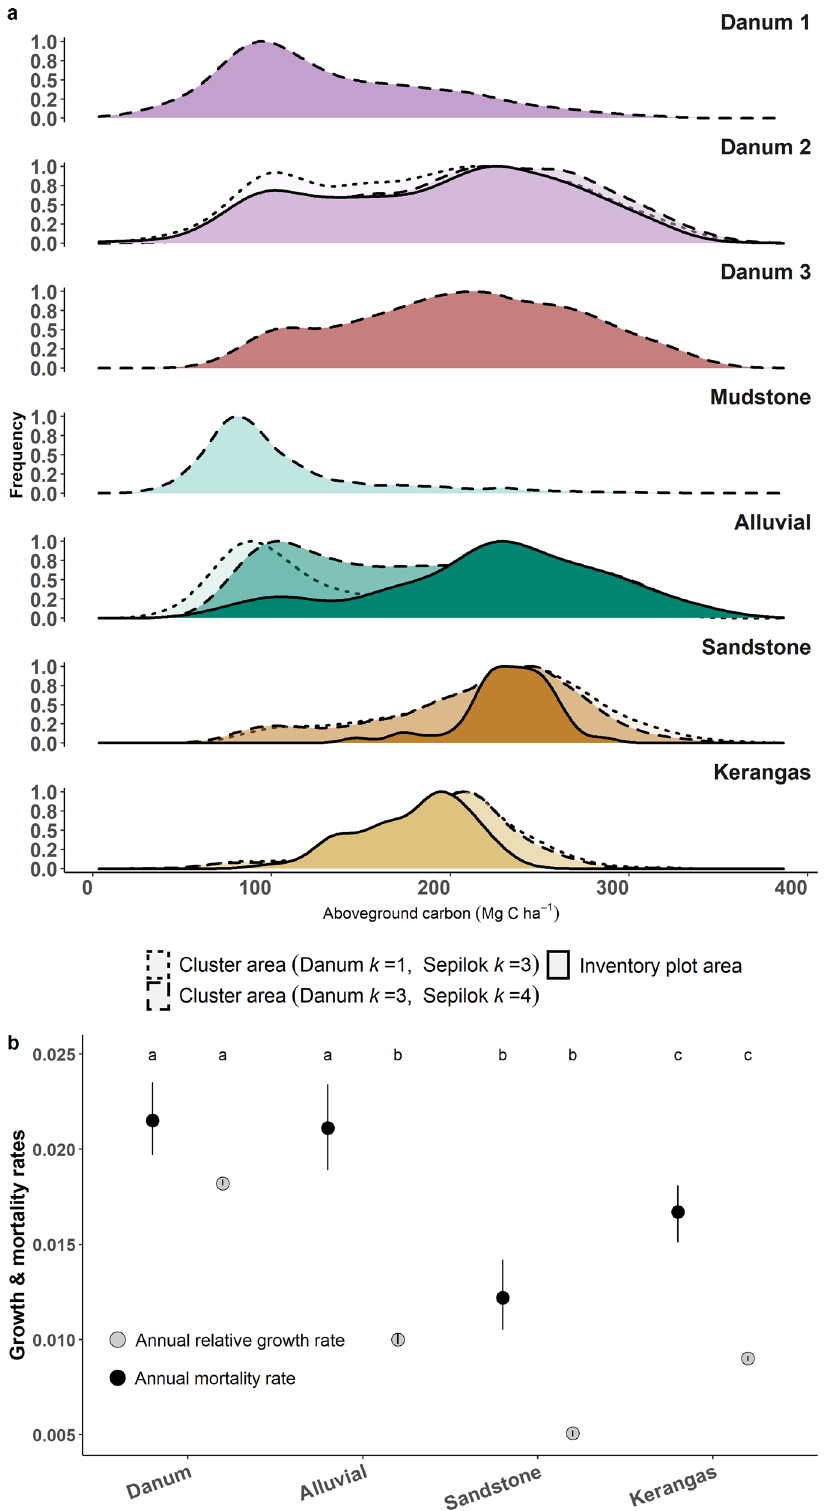
Fig. 4 Functional dynamics across forest types. a Aboveground carbon density for each fi eld inventory plot (solid line) compared to aboveground carbon for the entire forest type based on cluster results where k = 1 for Danum and k = 3 for Sepilok (dotted line) and k = 3 for Danum and k = 4 for Sepilok (dashed line). b Annual relative growth (gray) and mortality (black) rates for each forest type calculated from forest inventory plot data. Growth and mortality rates could not be calculated for the Mudstone forest type due to the lack of an inventory plot with repeat census measurements. Identical letters represent inventory plots with no signi fi cant difference in terms of carbon, mortality rates, and growth rates respectively, based on one-way ANOVA tests ( p < 0.01). Error bars in b indicate 95% con fi dence